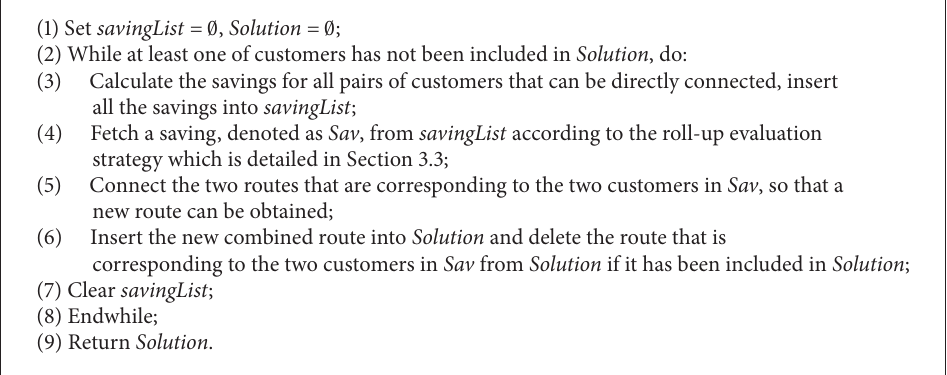
Algorithm 2: The procedure to construct an initial solution.